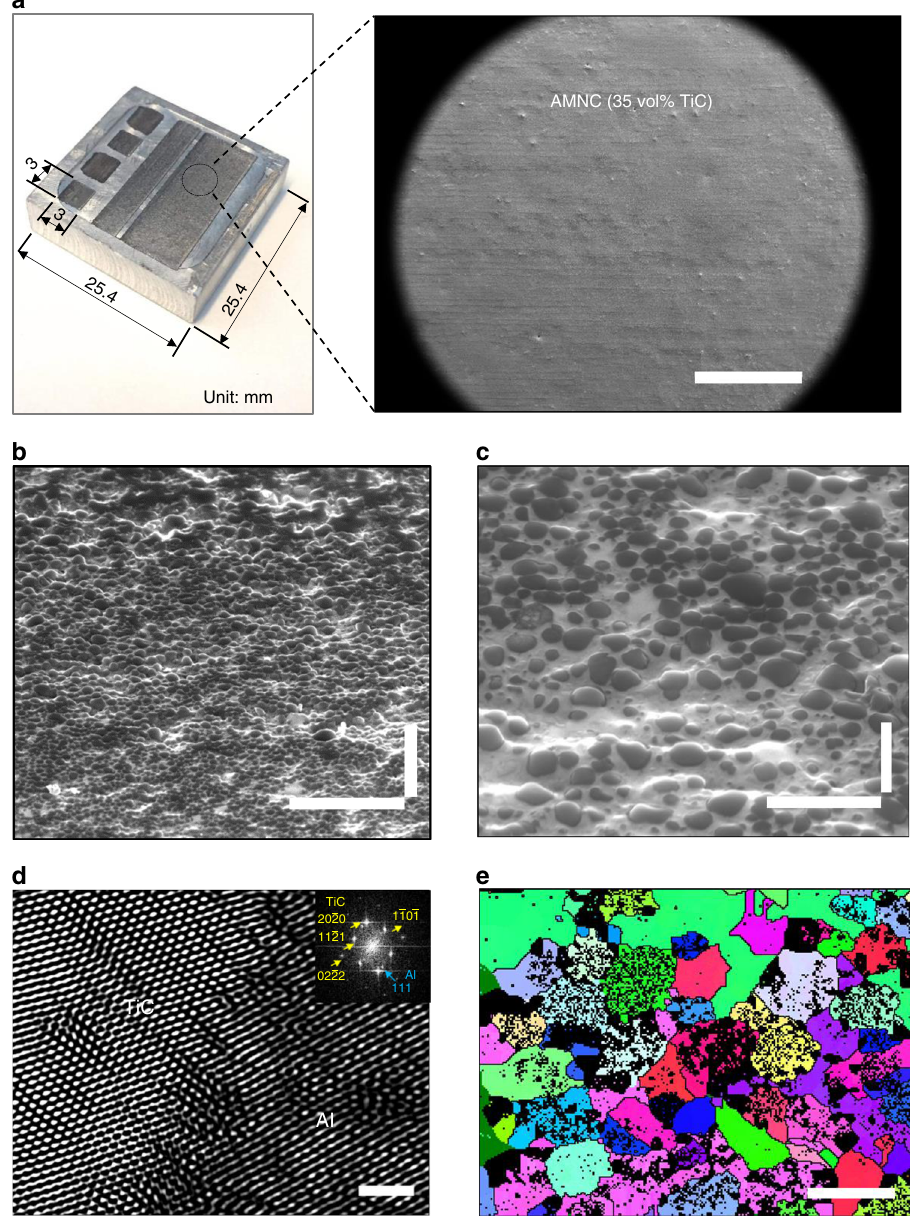
Fig. 2 Surface and micro/nanostructure of laser-deposited aluminum matrix nanocomposites (AMNC). a Top view of laser-deposited AMNC (35 vol.% TiC) specimens with dimensions of 3 mm × 3 mm, 3 mm × 18.5 mm, and 8 mm × 18.5 mm. The insert SEM image shows an area of the laser-deposited specimen. b , c 52° tilted cross-sectional SEM images of laser-processed AMNC (35 vol.% TiC) were captured under different magni fi cations, showing